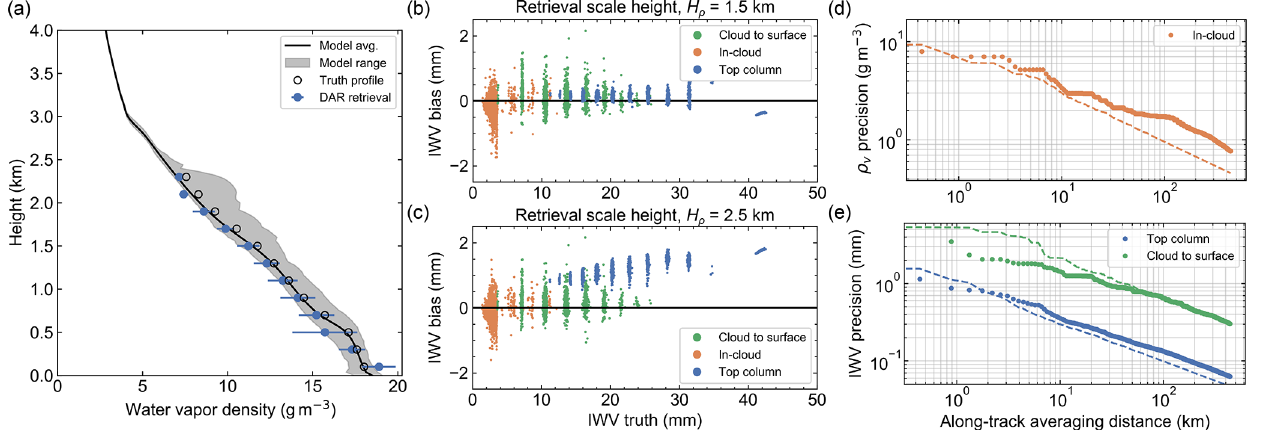
Figure 5. RICO DAR retrieval results. (a) Comparison of mean-retrieved and model in-cloud humidity profiles, depicted as in the GATE case (Fig. 3a). (b–c) IWV retrieval bias vs. truth for the three distinct column types and two different humidity retrieval scale heights of 1.5 and 2.5km. (d–e) Retrieval precision scaling with along-track averaging, similar to Fig. 3c, except sequential along-track transects are executed by cycling through all possible cross-track ( x )